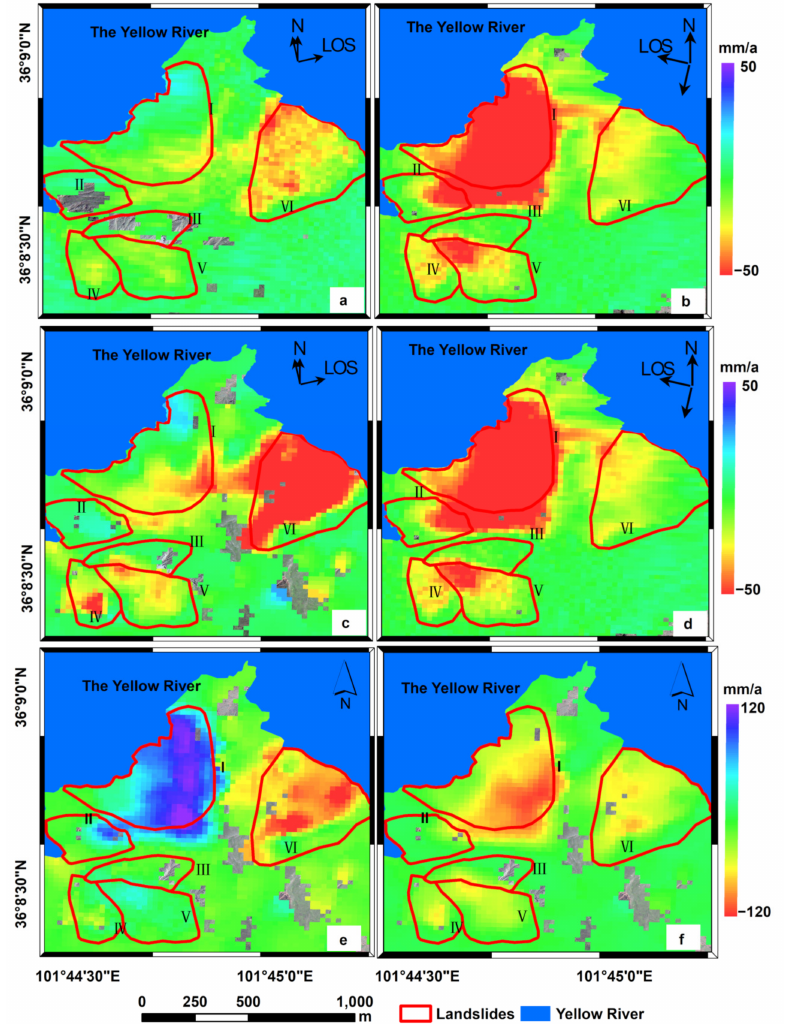
Figure 7. Deformation of the Lijia Gorge landslide group. ( a ) Deformation in the ascending line-of- sight (LOS) direction acquired using the STACKING technique; ( b ) deformation in the descending LOS direction acquired using the STACKING technique; ( c ) deformation in the ascending LOS direc- tion acquired using interferometric point target analysis (IPTA); ( d ) deformation in the descending LOS direction acquired using IPTA; ( e ) deformation in the E–W direction; and ( f ) vertical